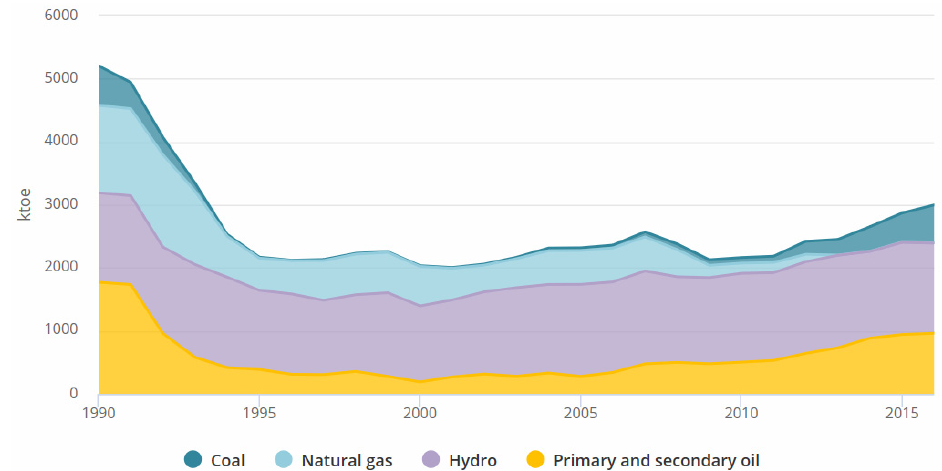
Figure 2. Total primary energy supply of Tajikistan by source. Reproduced with permission from [11], IEA, 2018.